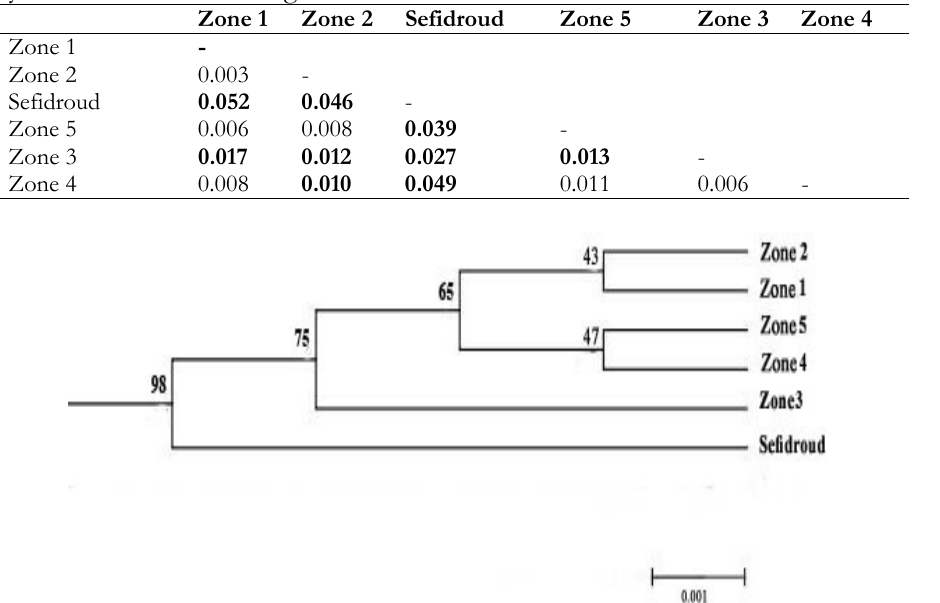
F IGURE 2. Unrooted neighbor-joining cluster analysis diagrams based on Cavalli-Sforza and Edwards’ (1967) chord distance for microsatellite markers in the south Caspian